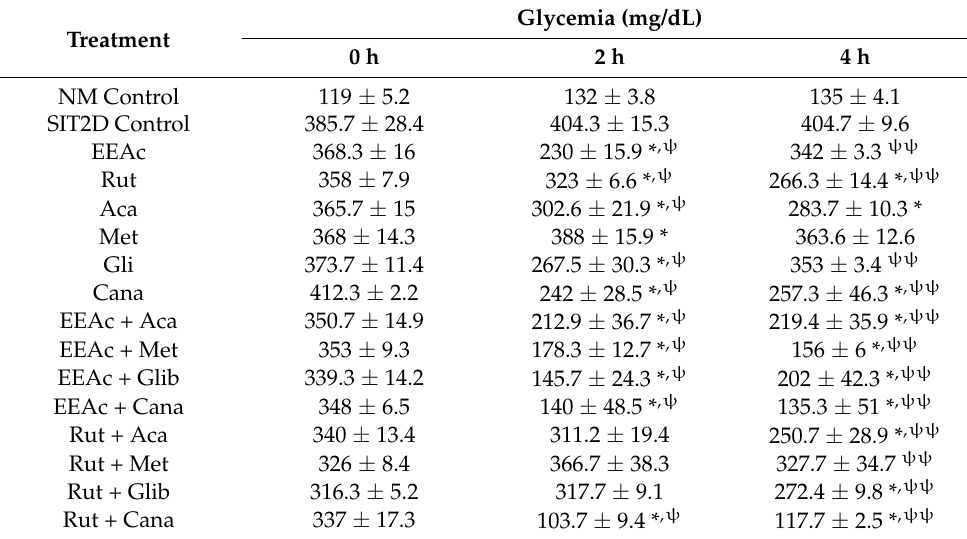
Table 1. Blood glucose levels of normoglycemic mice (NM) and streptozocin induced type 2 diabetic mice (SIT2D) at 0, 2, and 4 h, on the acute antihyperglycemic test.